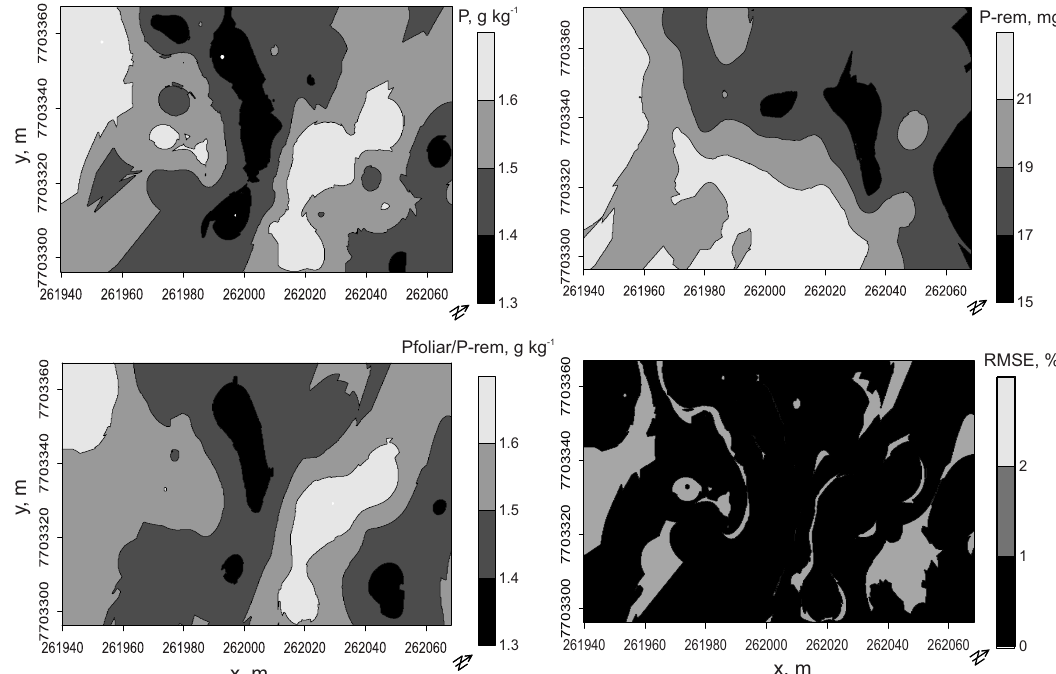
Figure 1. Spatial distribution maps obtained by ordinary kriging (foliar P and P-rem), cokriging (Pfoliar/P- rem) and root mean square error (RMSE) for the Coffea canephora Pierre cv